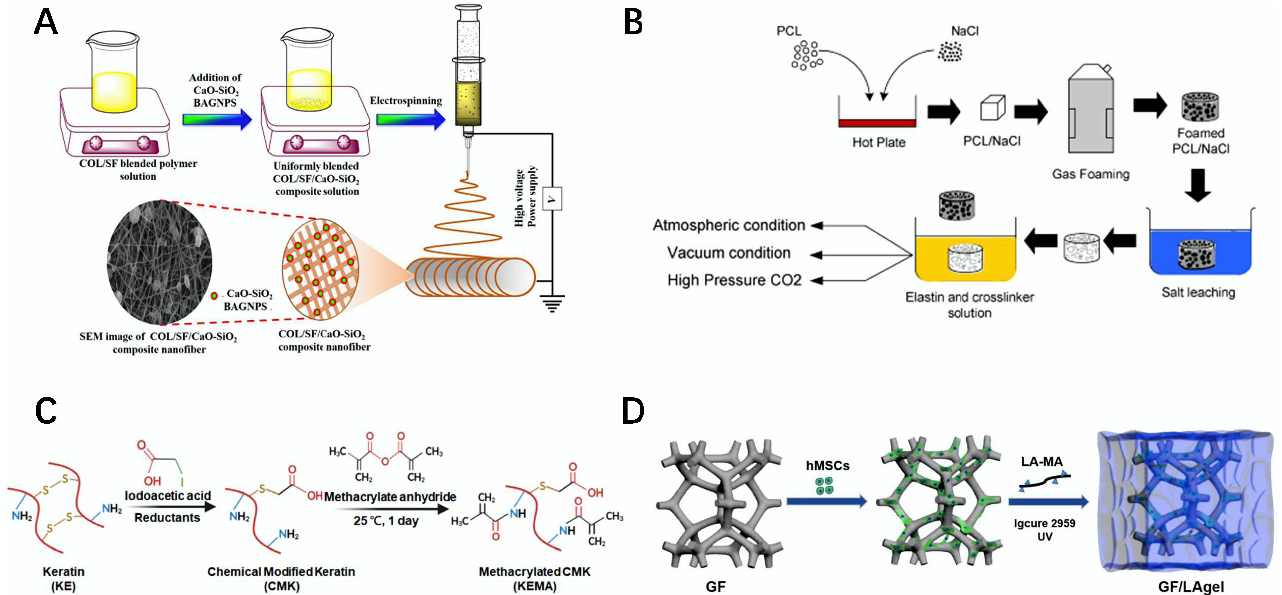
Figure 2. Schematic diagram of the preparation of biocomposite scaffolds and bio-inks using proteinaceous natural materials. ( A ) Schematic diagram of the preparation of the Col/SF/CaO-SiO 2 composite fibers [31]. ( B ) Schematic diagram of the preparation of the PCL/elastin composite scaffold [32]. ( C ) Schematic diagram of the preparation of the KEMA bio-ink [33]. ( D ) Schematic diagram of the preparation of the GF/LAgel composite scaffold [34].